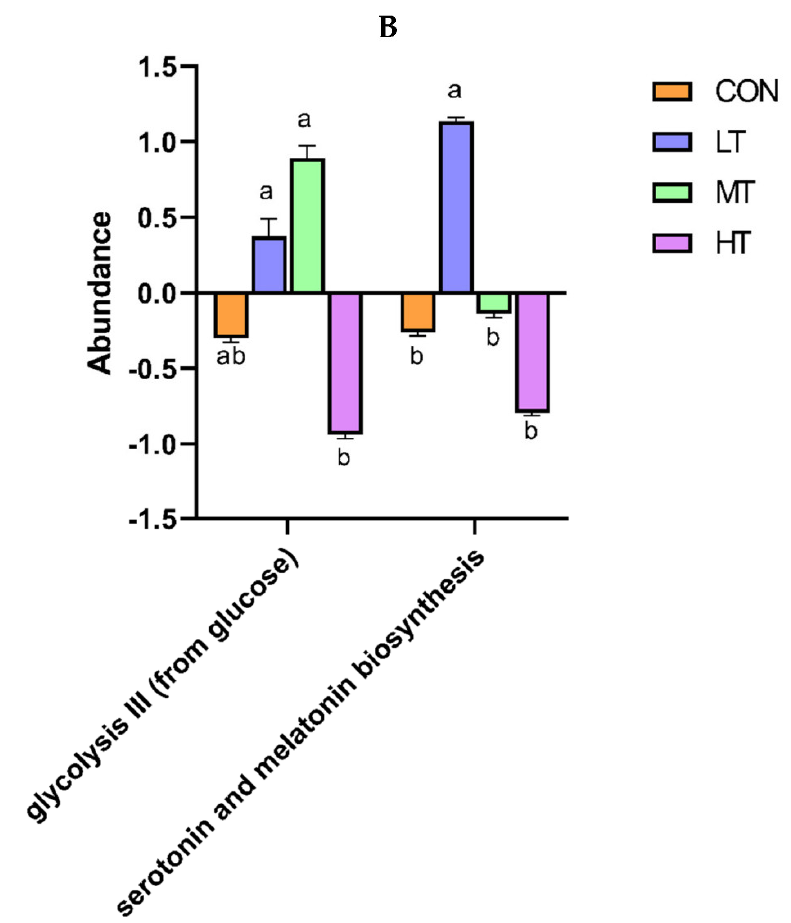
Figure 7. ( A ) Prediction of relative abundance of ruminal fungi metabolic functions by Metabolic Pathways From all Domains of Life (MateCyc). ( B ) Functional differences of ruminal fungi in four groups at MateCyc. The different letters are significantly different ( p < 0.05).